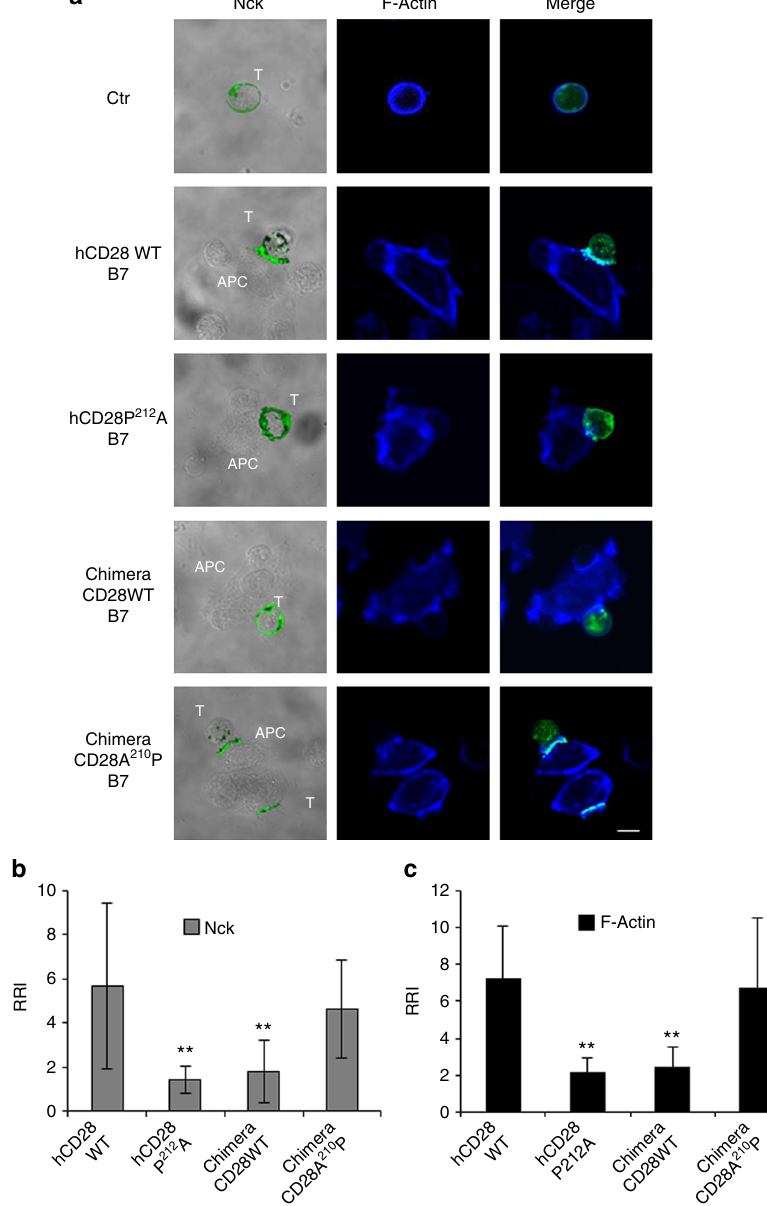
Fig. 7 P 212 within the C-terminal proline-rich motif of human CD28 is essential for Nck recruitment and actin polymerisation. a hCD28 WT or hCD28P 212 A or chimera containing the extracellular and transmembrane domain of human CD28 and the cytoplasmic tail of mouse CD28 (Chimera CD28WT) mouse CD28 mutant (Chimera CD28A 210 P) were transfected with 20 μ g of GFP-Nck (green) and then stimulated for 15 min in the absence (Ctr) or presence of Dap/B7 cells (B7). After fi xing and permeabilisation F-actin was stained with 633-conjugated phalloidin (blue) and analysed by confocal microscopy. The scale bar represents 10 μ m. b , c The relative recruitment index (RRI) of Nck ( b ) and F-actin ( c ) was calculated as described in Methods and represents the mean ± SD of 15 conjugates analysed in each group. Mean values: Nck, hCD28WT = 5.688 ± 3.7, hCD28 P212 A = 1.44 ± 0.6, Chimera CD28WT = 1.8 ± 1.4, Chimera CD28A 210 P = 4.6 ± 2.1; F-actin, hCD28WT = 7.2 ± 2.9, hCD28 P212 A = 2.1 ± 0.8, Chimera CD28WT = 2.4 ± 1.1, Chimera CD28A 210 P = 6.7 ± 3.8. Asterisks ** p < 0.01 calculated by Student ’ s t- test compared with hCD28WT. The results are representative of three independent